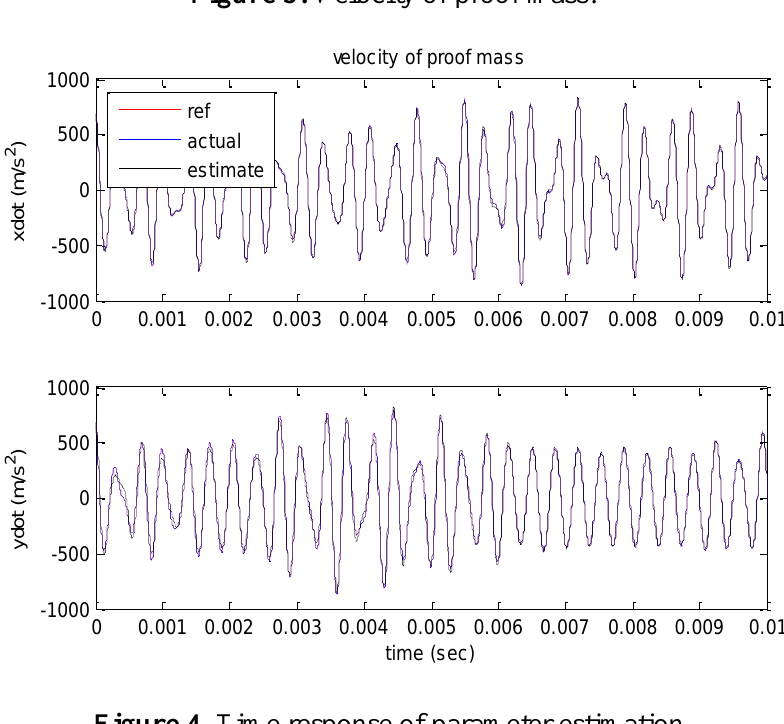
Figure 3. Velocity of proof mass.